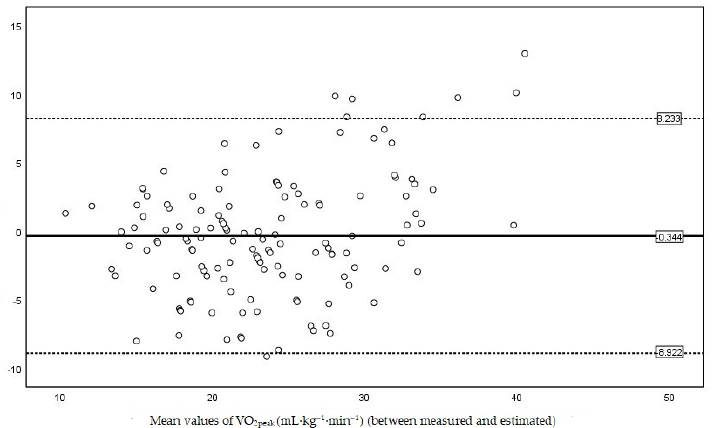
Figure 2. Bland and Altman plot. Intraindividual difference in VO 2peak (mL · kg − 1 · min − 1 ) between two exercise tests (MSWT vs. CPET) plotted against intraindividual mean values of the exercise tests (MSWT and CPET). The central line represents the mean of the intraindividual differences, and the flanking lines represent the 95% limits of agreement.